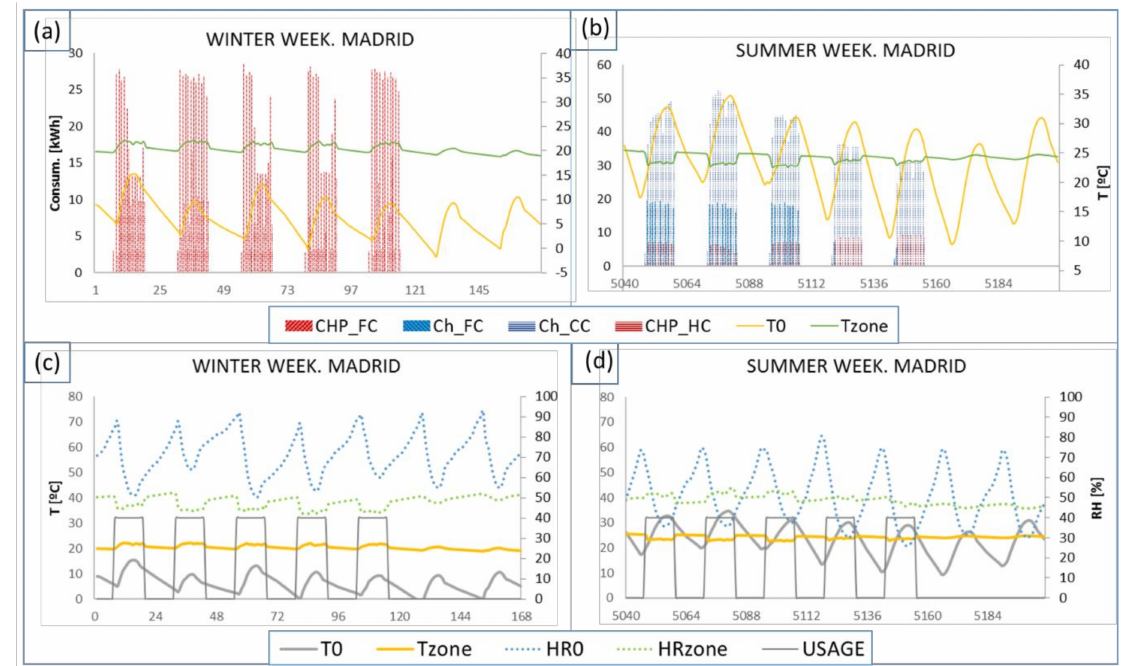
Figure 15. Indoor conditions of a representative ( a , c ) winter week (1st of January) and ( b , d ) summer week (1st of August) in